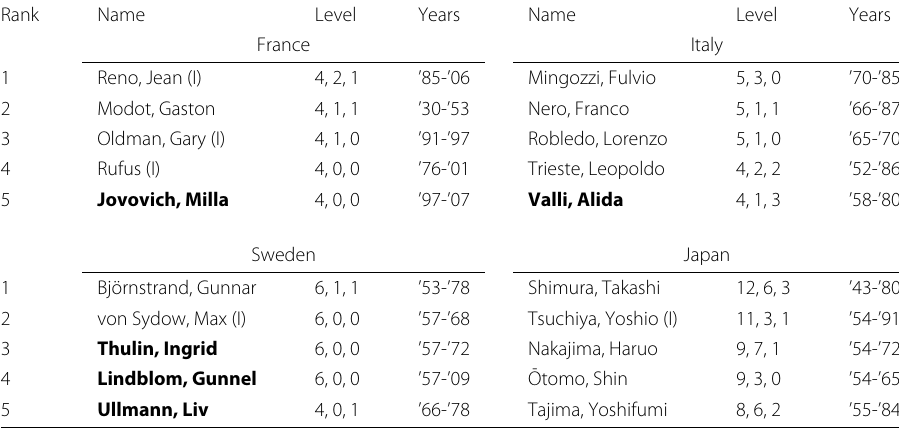
Table 11 Top 5 actors (of any gender, actresses in bold) by country, for movies produced in France, Italy, Sweden and Japan. For each individual we report the number of movies he has starred in the country that reached top the 5%, 10% and 15% influence in their year of release, and their range of release